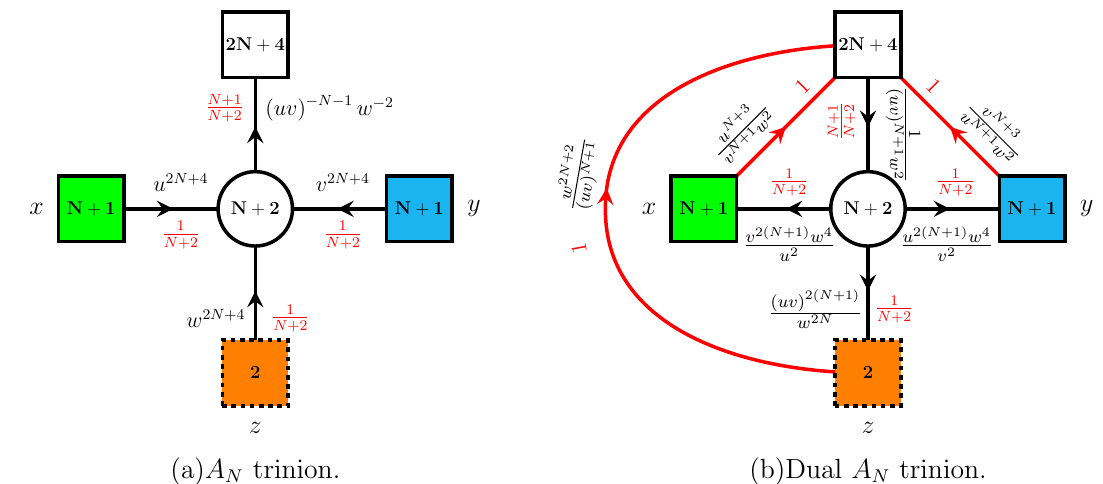
Figure 11: Quiver of the A trinion theory and its Seiberg dual. This trinion is ob- N ) minimal conformal matter theory on a tained by compactifying the ( D , D N + 3 N + 3 sphere with two maximal SU ( N + 1 ) punctures and a minimal SU ( 2 ) puncture with flux breaking the SO ( 12 + 4 N ) symmetry to SO ( 8 + 4 N ) × SU ( 2 ) × U ( 1 )